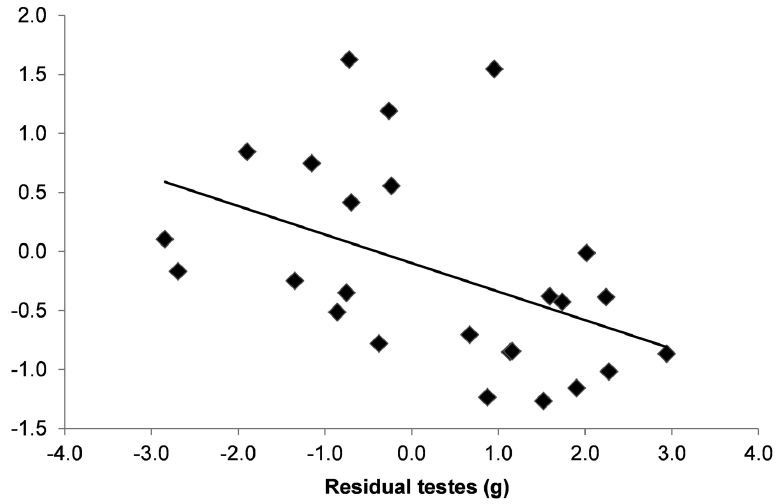
Figure 1. Relationship between residual masses of spleen and testes ( r 2 =0.21, F 1,23 =6.07, P =0.022) calculated from least squares regression against body mass in Xerusinauris . Note: two points are overlapping at x=1.1, y= 2 0.85.